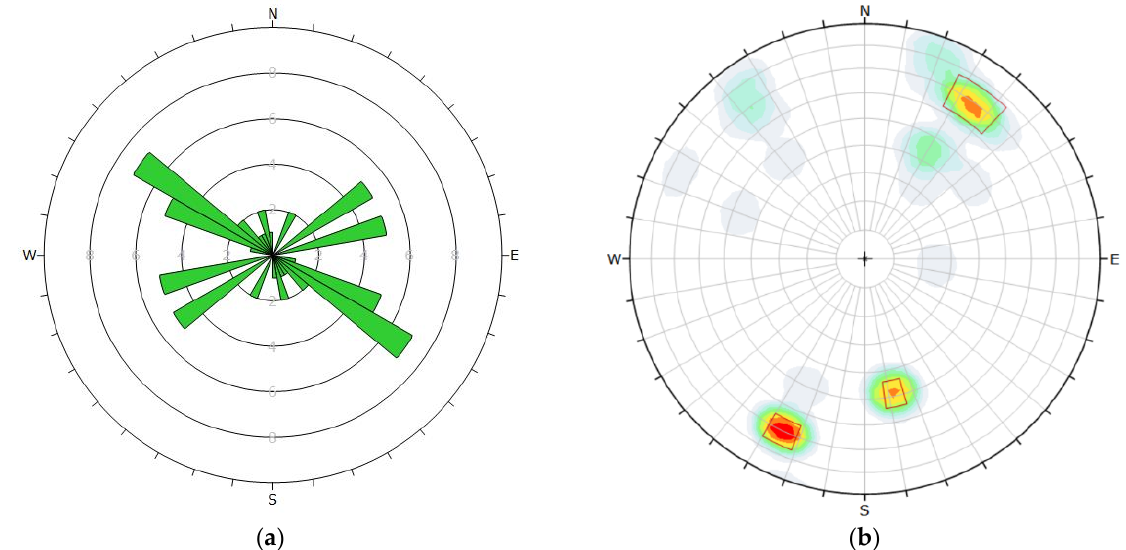
Figure 10. Poles and apparent strikes of major discontinuities, ( a ) rosette preset view, ( b ) polar view.